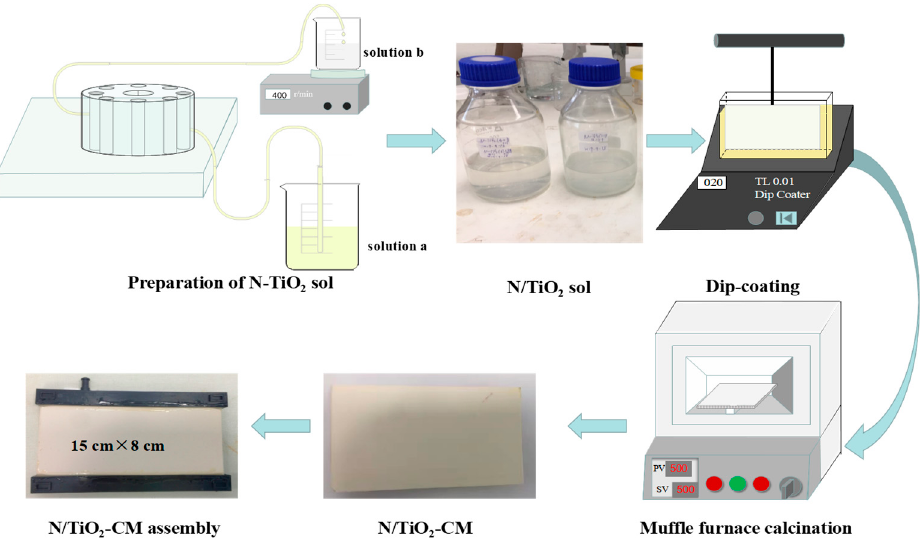
Figure 1. Preparation process of PRCM of N-TiO 2 -CM.